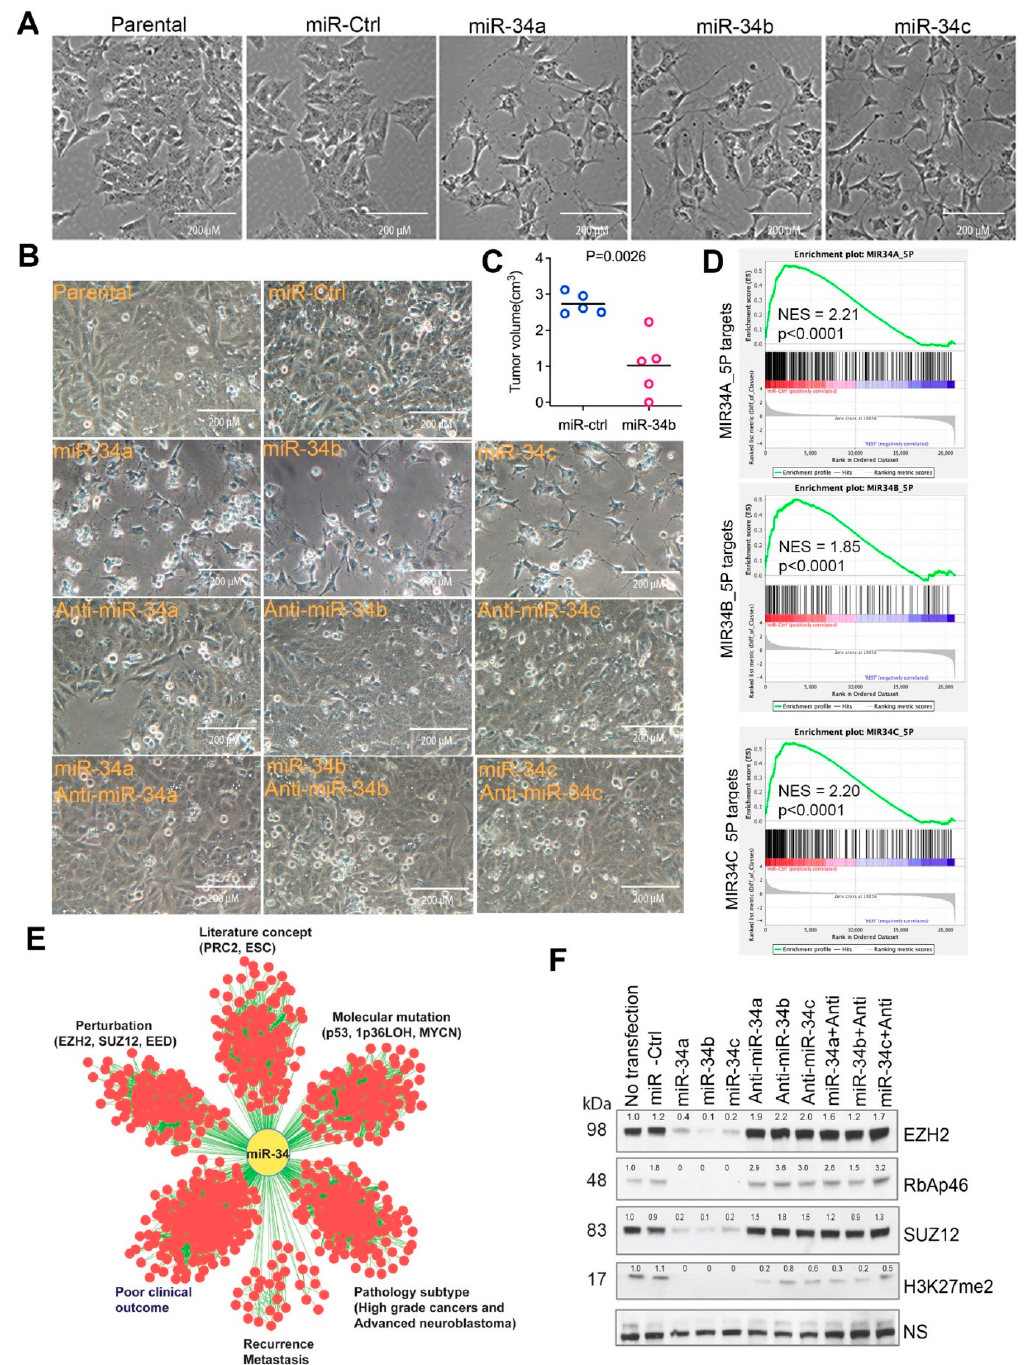
Figure 1. miR-34 is tumor suppressive and targets multiple gene signatures and PRC2 complex. ( A ) Neurite outgrowth after 72 h transfection of miR-34 paralogs into BE2C cells. Photos were taken under a microscope (magnification, 20 × ). ( B ) Cell morphology change after 72 h transfection of BE2C cells with miR-34 and anti-miRs. Photos were taken under microscope (20 × ). ( C ) Tumor volume in BE2C xenografts (n = 5) with lentiviral-mediated miR-34b expression. ( D ) Gene set-enrichment analysis results for the genes downregulated by miR-32 targets (miR-34A-5P normalized enrichment score (NES) = 2.21, p < 0.0001; mir-34B-5P NES = 1.85, p < 0.0001; miR- 34C-5P NES = 2.20, p < 0.0001). ( E ) Concept analysis of miR-34 signature derived from BE2C cells. The association of the signatures with p < 0.000001 and odds ratio >2 was presented by Cytoscape program. ( F ) Western blotting for PRC2 components with indicated antibodies